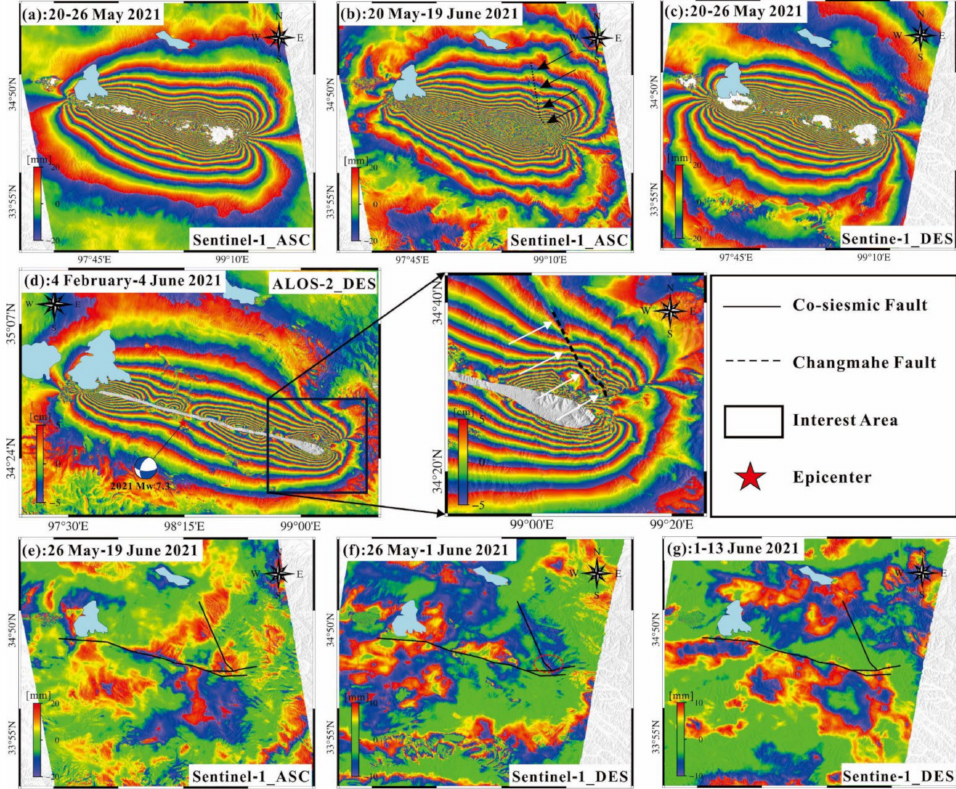
Figure 5. Co- and post-seismic surface deformation in the seismic zone. The red star denotes the epicenter of the 2021 Maduo earthquake, and the black dashed line indicates the distinguished discontinuous fringe along the Changmahe fault. Co-seismic surface deformation observed by ascending Sentinel-1 satellite orbital track with different periods of 20–26 May 2021 ( a ) and 20 May–19 June 2021 ( b ). Co-seismic surface deformation observed by descending satellite orbital tracks of Sentinel-1 (( c ): 20–26 May 2021) and ALOS-2 (( d ): 4 February–4 June 2021). ( e ) Post-seismic InSAR deformation observed by ascending Sentinel-1 satellite orbital track within the period of 26 May–19 June 2021. Post-seismic InSAR deformation observed by descending Sentinel-1 satellite orbital track with different periods of 26 May–1 June 2021 ( f ) and 1–13 June 2021 ( g